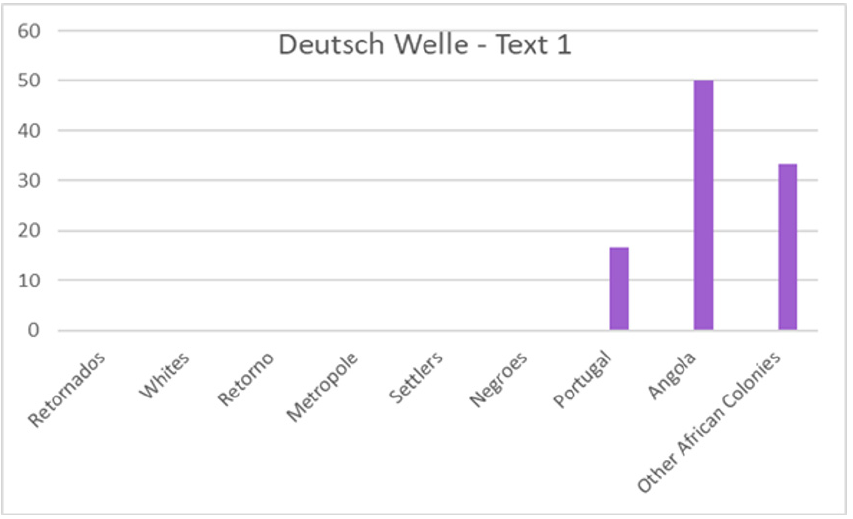
Figure 9. Most frequent words in the text “Baixas na guerra colonial são maiores do que se pensava”. Source: Deutsche Welle (2021) [23].